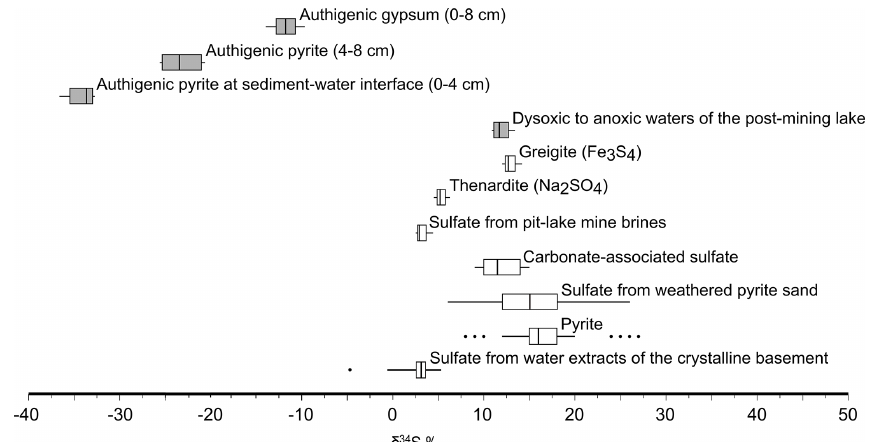
Figure B2. A comparison of the ranges of reported δ 34 S values of potential sources of oxidized sulfur to Lake Medard (after Šmejkal, 1978; Krs et al., 1990, for greigite); the ranges of sulfate-rich bottom water column and authigenic gypsum and pyrite in the upper anoxic sediments (this work) are also shown (filled